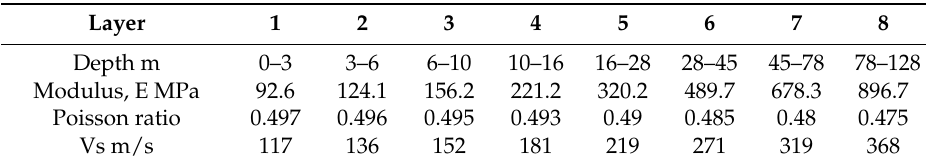
Table 1. Material properties to simulate sediments at different depths below the